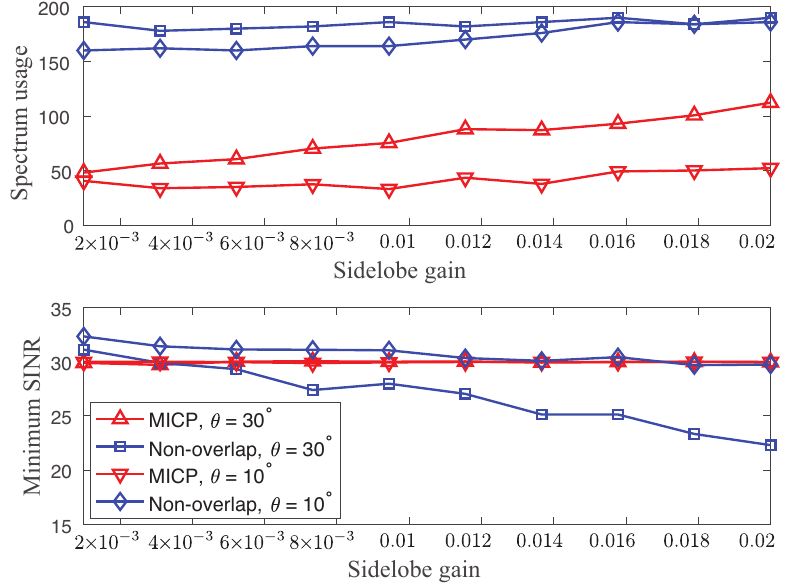
Figure 6. Expected values of spectrum usage ( top ) and minimum SINR ( bottom ) using the solutions of both the integer non-linear problem (INP) and MICP as functions of different sidelobe gains ( g 2 = 0.001, . . . ,0.02) with θ = 10 ◦ , 30 ◦